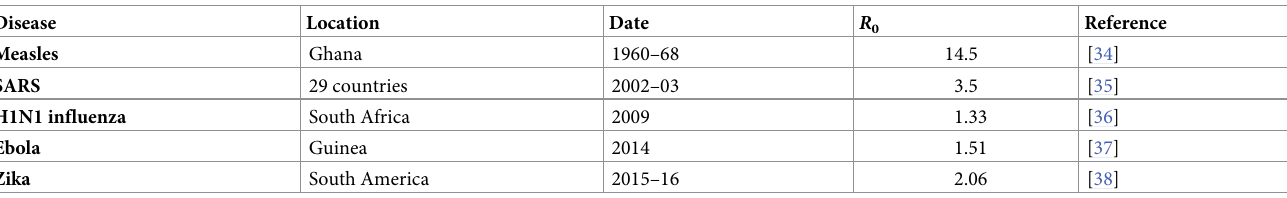
Table 3. Estimated R 0 for various